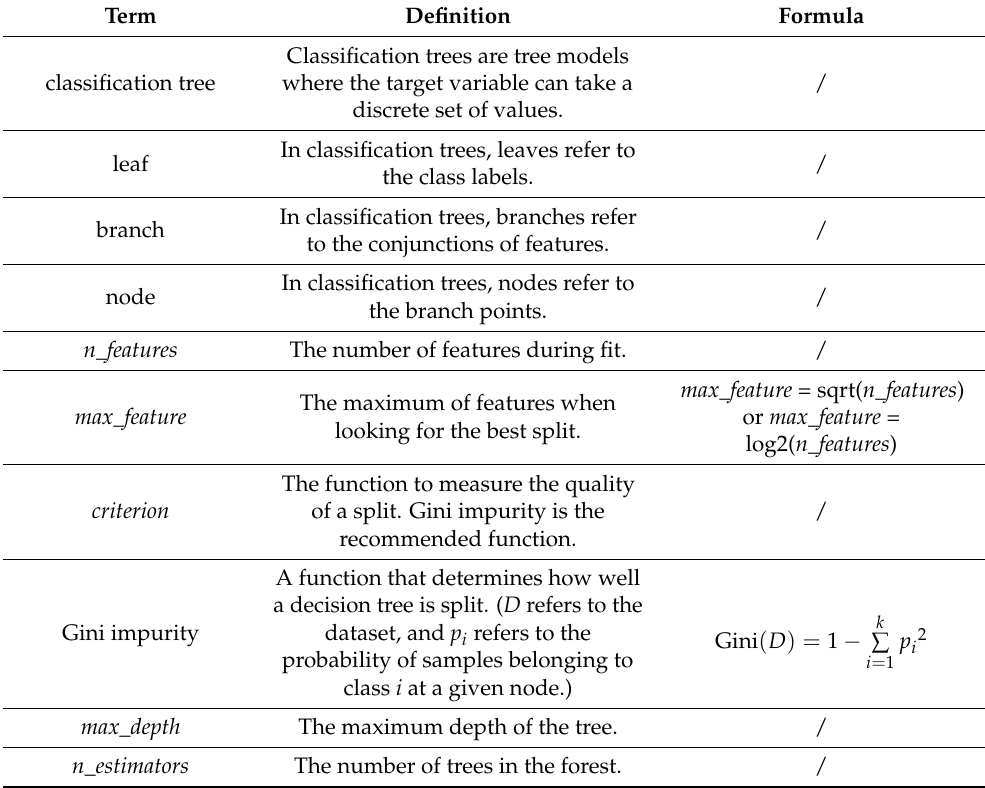
Table A1. The definitions of terms related to the random forest classifier (the terms in italic font refer to the input parameters for the random forest classifier). Term Definition Formula Classification trees are tree models classification tree where the target variable can take a discrete set of values.